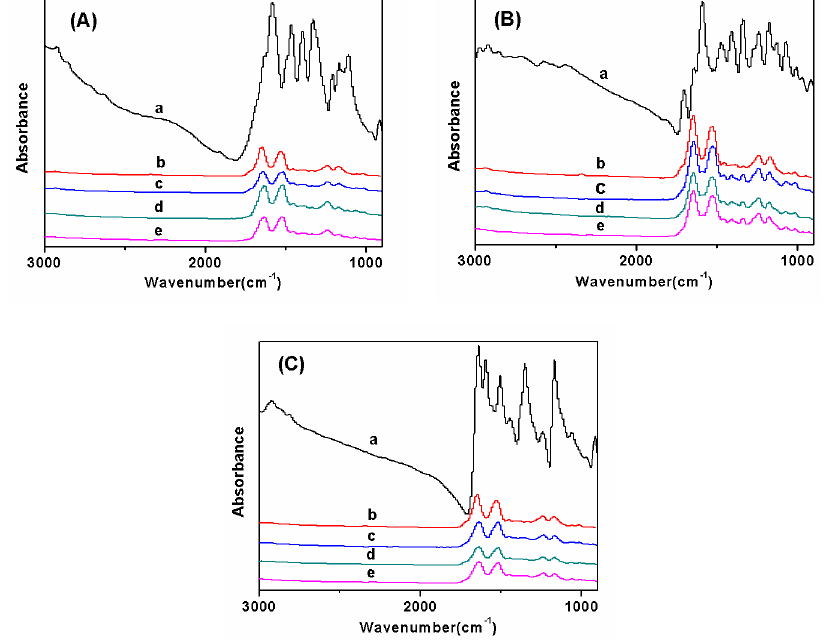
Figure 4. FTIR spectra of fluorescent SF nanofibers with different fluorescent dyes: ( A ) FS, ( B ) RB, and ( C ) AO; control sample: ( a ) fluorescent dyes; ( b ) pure SF nanofibers; the concentration of SF in electrospinning solution with 1.0 wt% fluorescent dyes was ( c ) 6.0 wt%, ( d ) 8.0 wt%, and ( e ) 10.0 wt%, respectively.